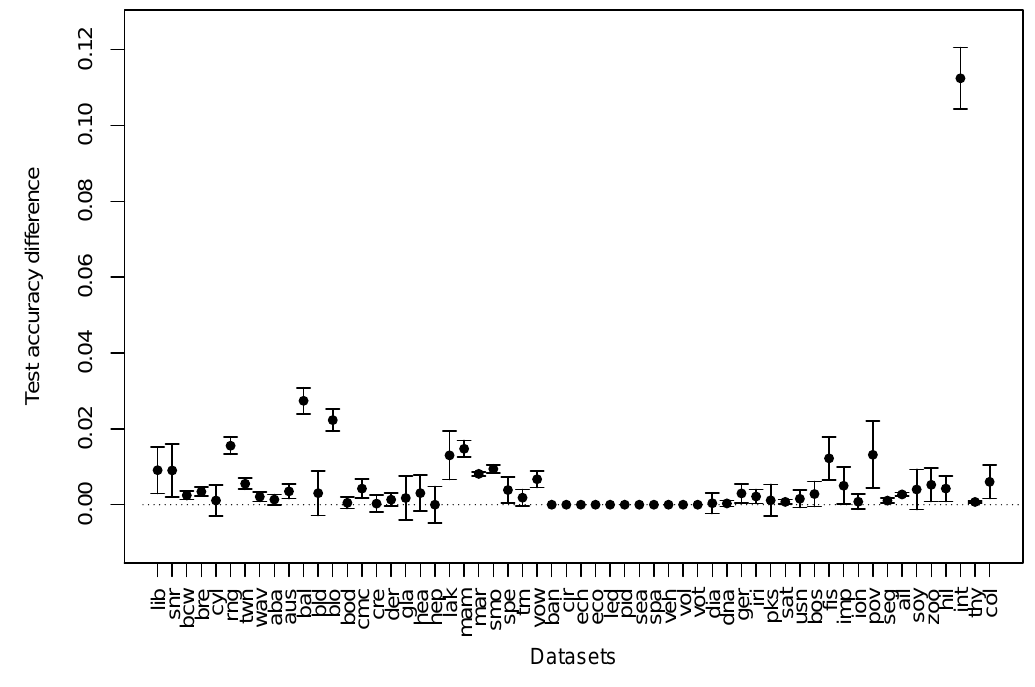
Figure 3. Confidence intervals of accuracy differences between the optimal m and the default m . The difference is significant when the confidence interval does not contain